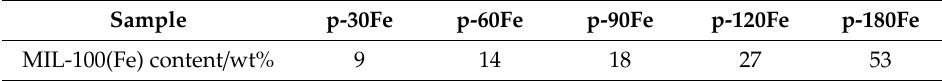
Figure 2. ( a ) FTIR spectra, and ( b ) TGA thermograms of the as-prepared photocatalysts. Table 1. Weight ratio of MIL-100(Fe) in the composites.